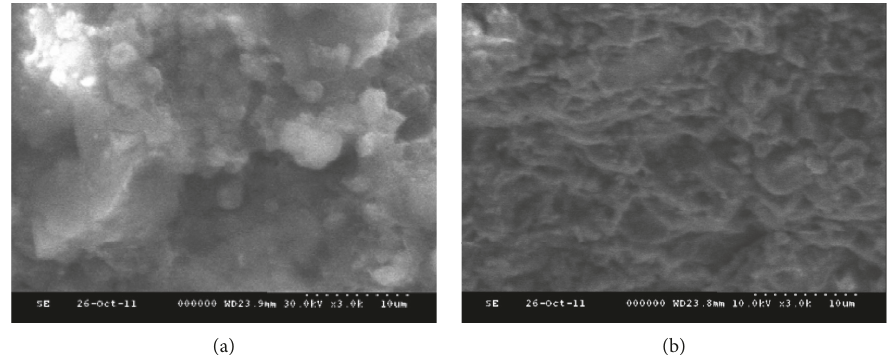
Figure 11: Micrograph of the carbonaceous mudstone before and after modification. (a) Before curing ( × 3000 times). (b) Cement dosage is 30%.